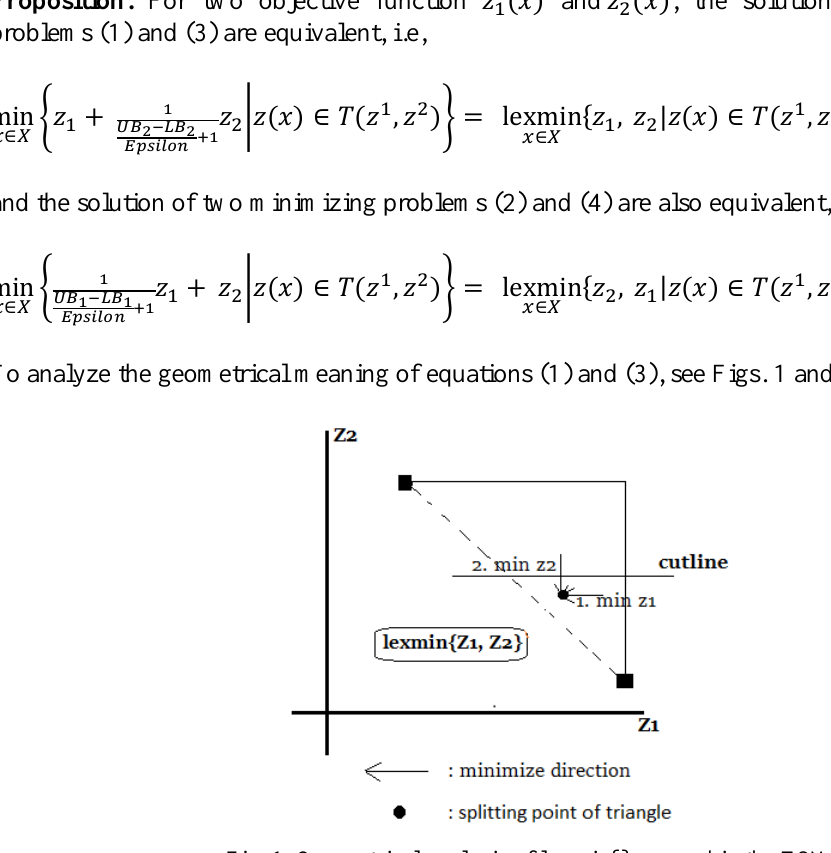
Fig. 1. Geometrical analysis of lexmin{} as used in the TSM